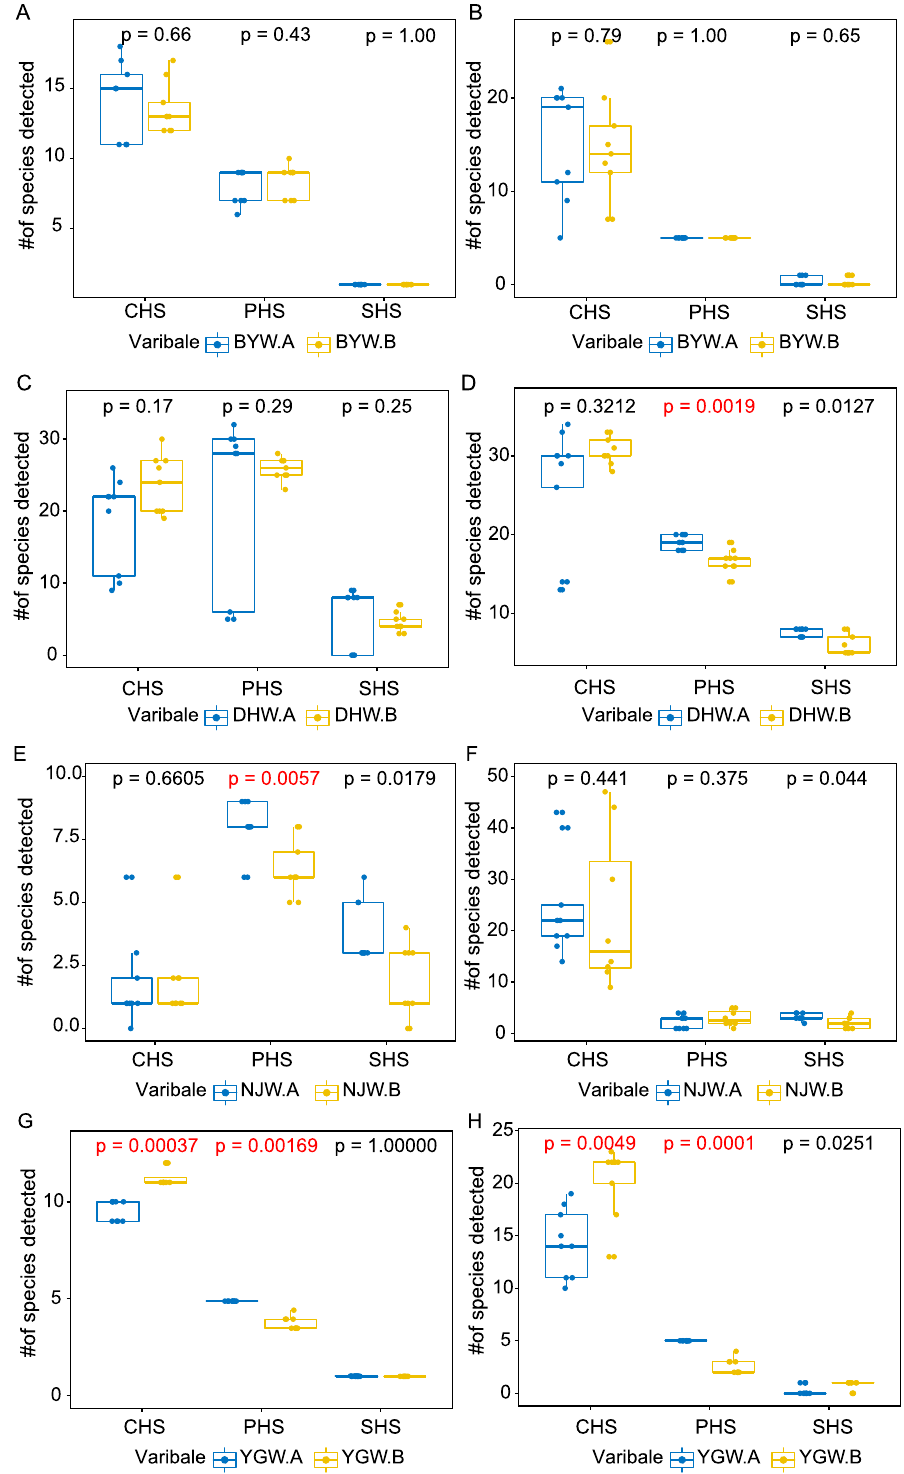
Figure 2. The distribution of detected species in four representative TCM preparations bought from two manufacturers based on ITS2 and trnL . ( A ) BYW samples based on ITS2; ( B ) BYW samples based on trnL ; ( C ) DHW samples based on ITS2; ( D ) DHW samples based on trnL ; ( E ) NJW samples based on ITS2; ( F ) NJW samples based on trnL . ( G ) YGW samples based on ITS2; ( H ) YGW samples based on trnL . PHS prescribed herbal species, SHS substituted herbal species, CHS contaminated herbal